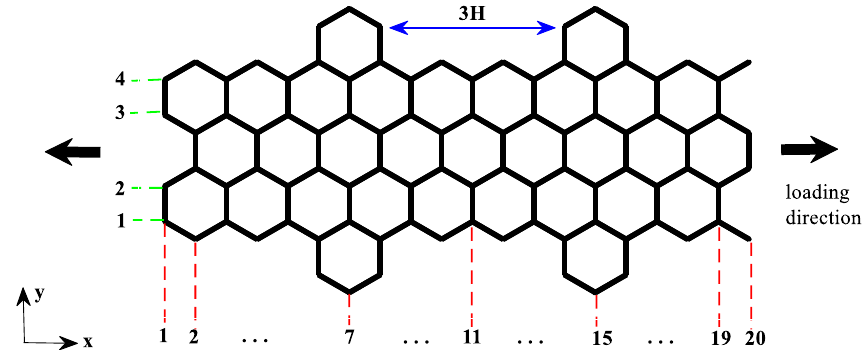
Figure 2. Schematic of cove-edged graphene nanoribbons (CGNR) with the definition of parameters NL (number of carbon–carbon dimer lines along the ribbon length (x direction)), NW (number of carbon–carbon dimer lines along the ribbon width (y direction)) and n H (distance between the hexagons at cove-typed edges).